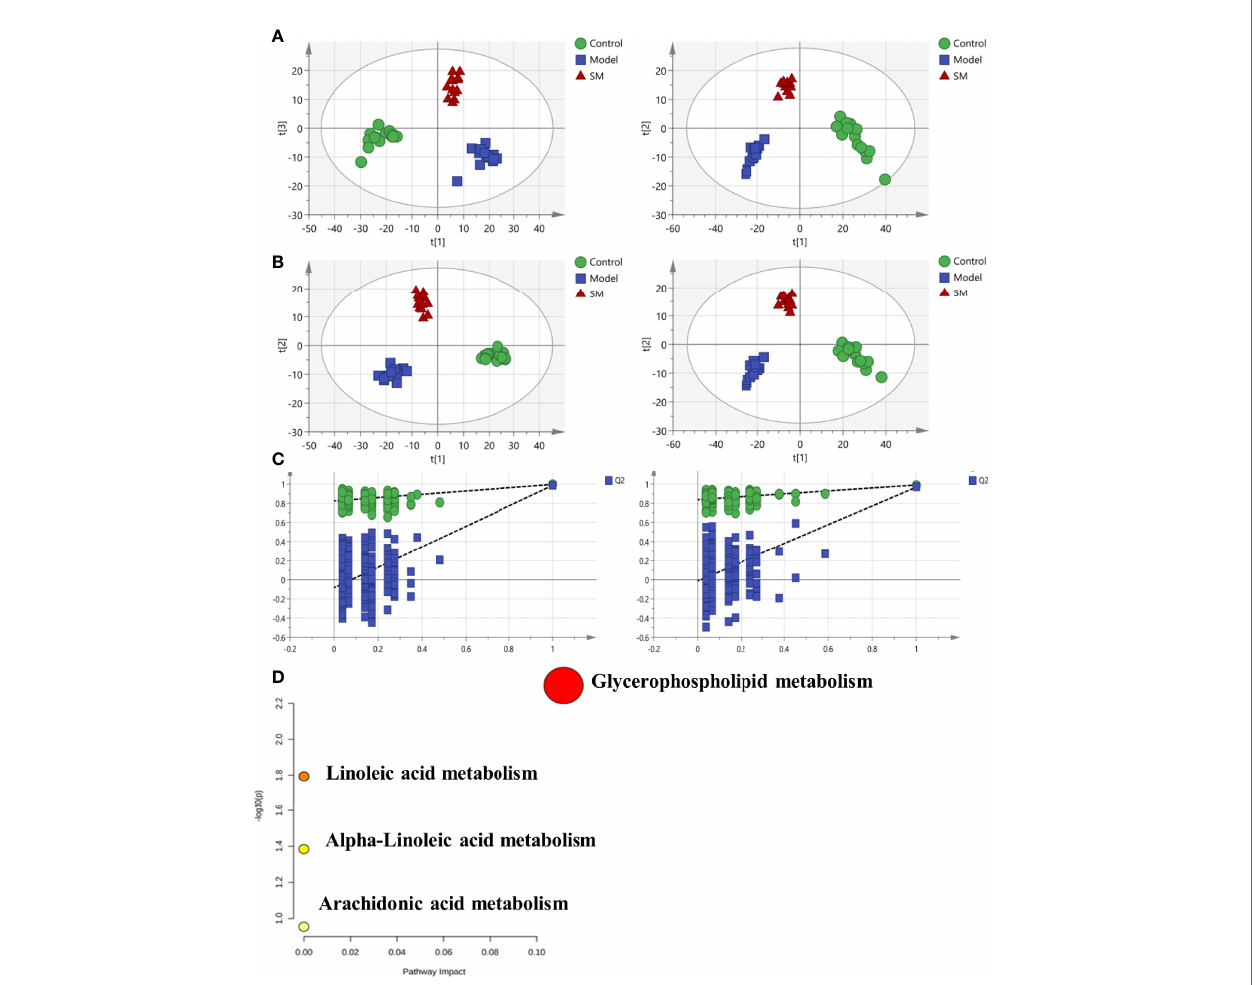
FIGURE 2 | (A) Principal component analysis (PCA) model results in positive and negative modes. (B) Supervised analysis by PLS-DA. (C) Validation of the PLS-DA model by the 200-time permutation test. (D) KEGG pathway analysis for the identi fi ed